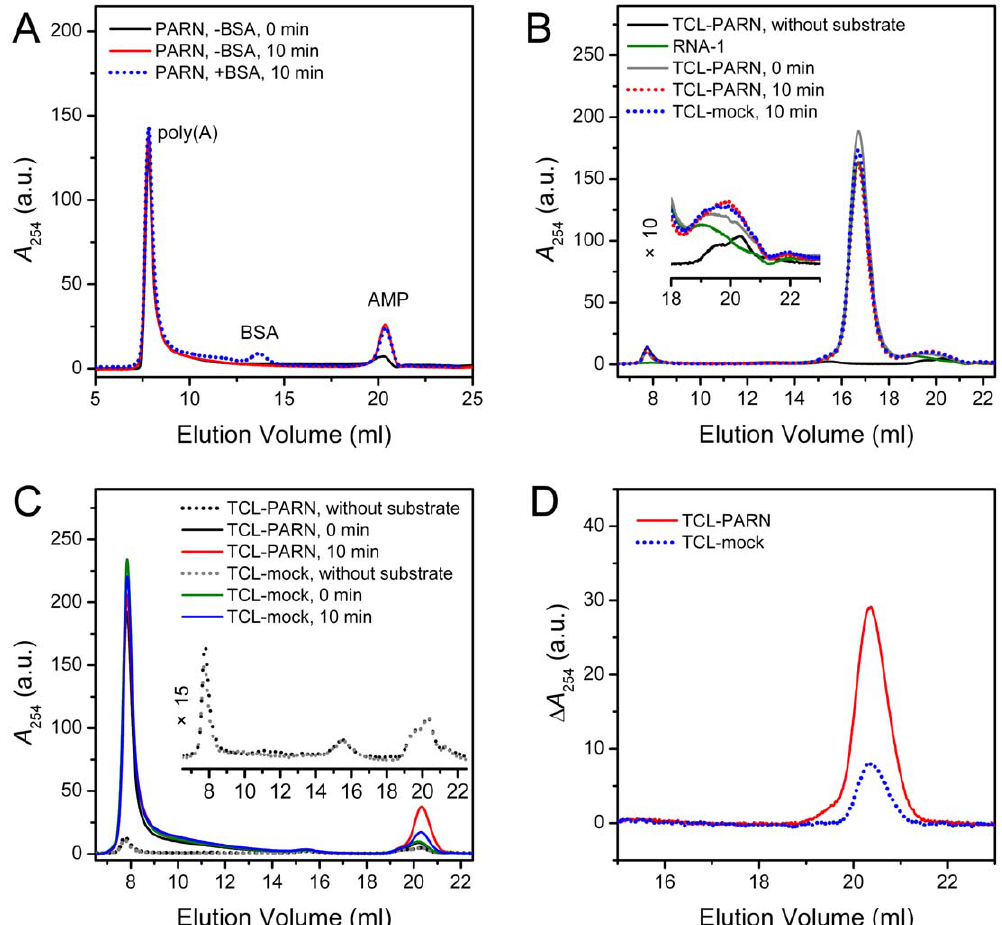
Figure 8. SEC assay of deadenylases in protein mixtures or crude cell extracts. (A) SEC profiles of reaction solutions in the presence or absence of BSA. The final concentrations of PARN, BSA and poly(A)-lot1 were 0.001, 0.2 and 0.1 mg/ml, respectively. The other assay conditions were the same as those in Figure 2. (B) SEC assay of the total cell lysates (TCL, 1:5 dilution) of HEK-293T cells using a non-poly(A) substrate (designated as RNA-1, 5 9 -GGAGCUCUGUCCUAUGUAU-3 9 ). The concentration of RNA-1 was 10 m M. The HEK-293T cells were transfected by either the pcDNA3.1 control vector (TCL-mock) or FLAG-PARN (TCL-PARN). The inset shows the high-magnification images of the peaks around the volume where the AMP eluted (20.3 ml). (C) SEC assay of poly(A) degraded by TCL-mock or TCL-PARN. The concentration of the substrate poly(A)-lot1 was 0.1 mg/ml. The inset shows the high-magnification images of SEC profiles of TCL without the addition of the substrate. (D) The difference profiles obtained by subtracting the SEC profiles recorded after 10 min reaction by that at 0 min.